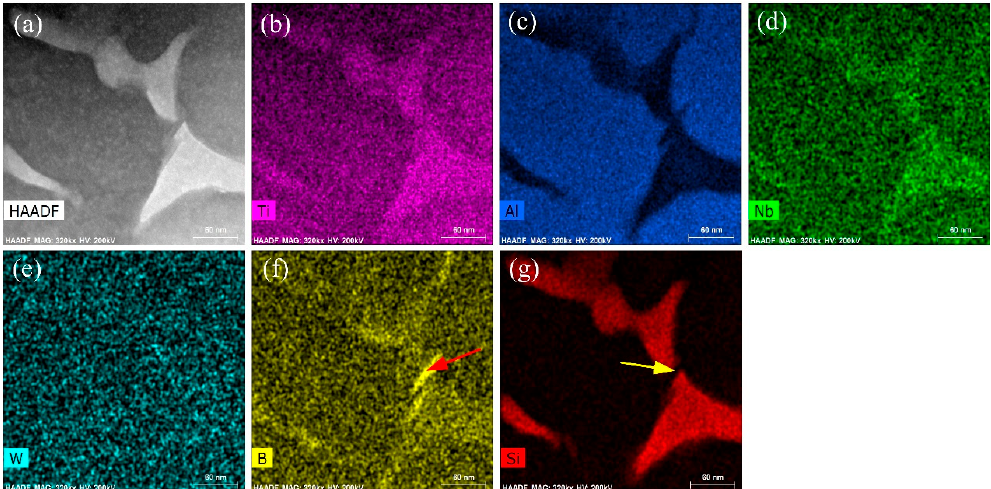
Figure 3. EDS chemical mapping of RS Ti-44Al-8Nb-0.2W-0.2B-1.5Si alloy: ( a ) The corresponding STEM-HADDF image; ( b ) Ti-K α ; ( c ) Al-K α ; ( d ) Nb-K α ; ( e ) W-K α ; ( f ) B-K α ; and ( g ) Si-K α .